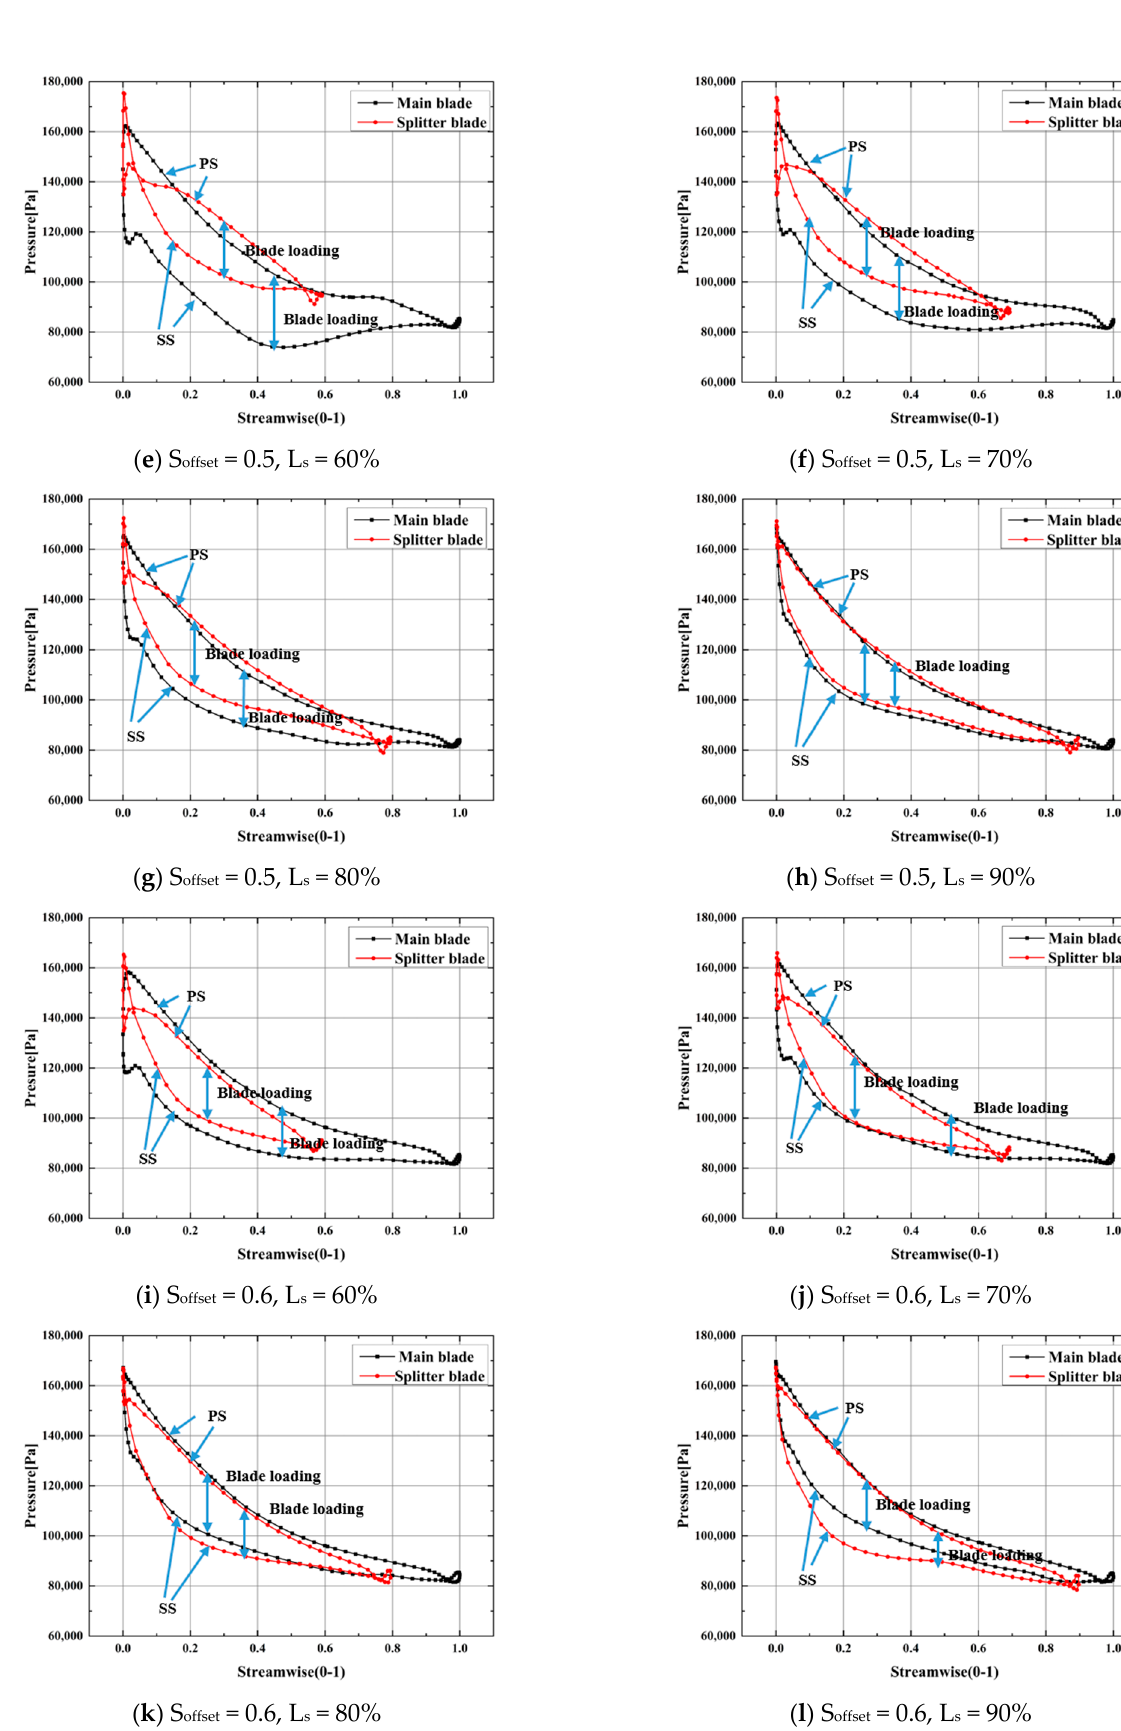
Figure 9. Blade loading chart.